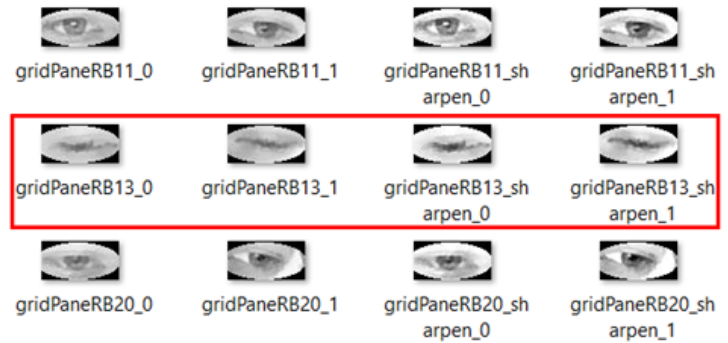
Figure 3. An example of blink eye images for the point (1 and 3).